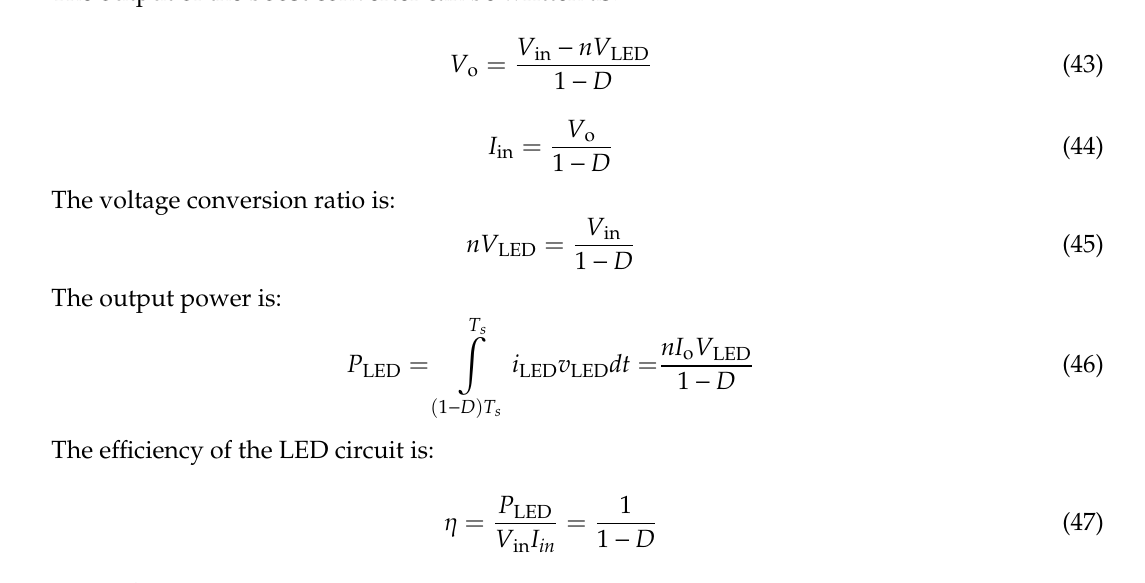
Figure 8. Simplified LED Boost converter.